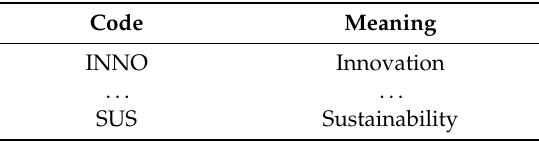
Table 4. Evaluation sheet 3, meaning of